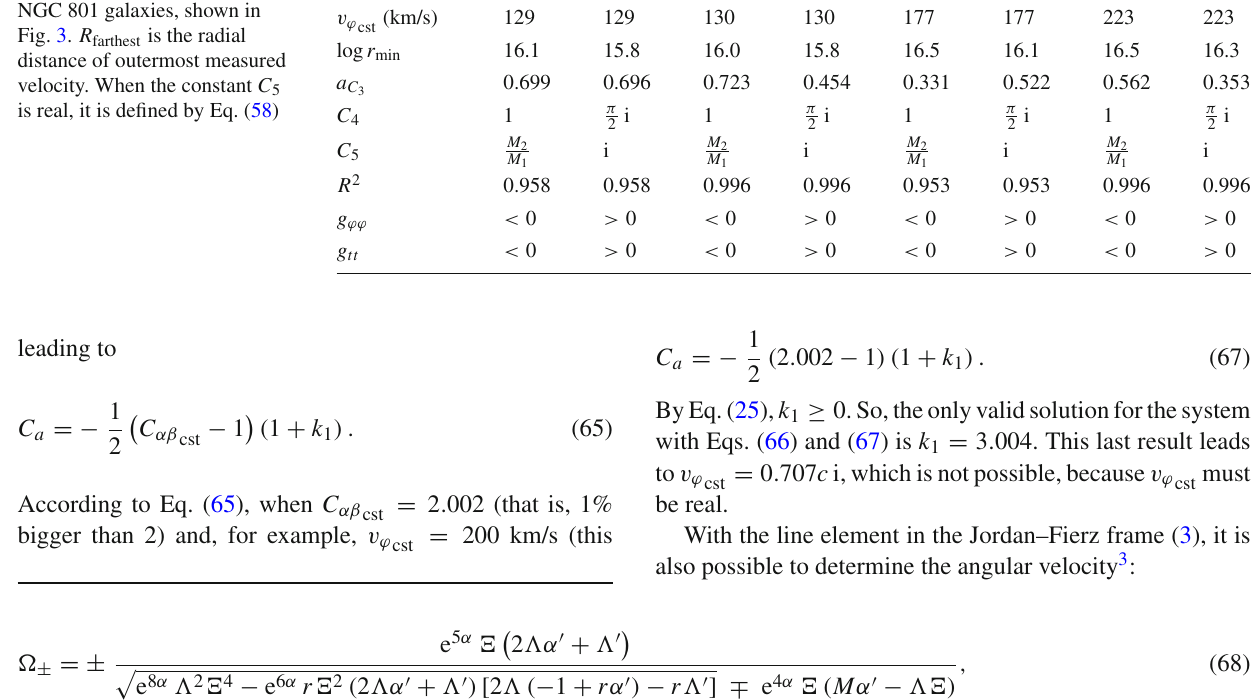
Table 1 Values of the components g tt and g ϕϕ , the constants and the determination coefficients for the fits of the function (48) made for NGC 701, NGC 1087, NGC 3672 and NGC 801 galaxies, shown in Fig. 3. R farthest is the radial distance of outermost measured velocity. When the constant C 5 is real, it is defined by Eq.